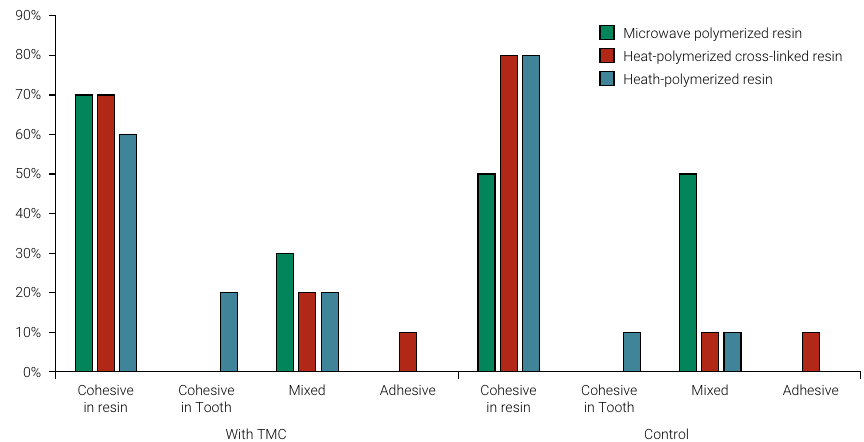
Figure 3. Distribution, in percentage, of the fracture types for each group. (TMC = Thermomechanical